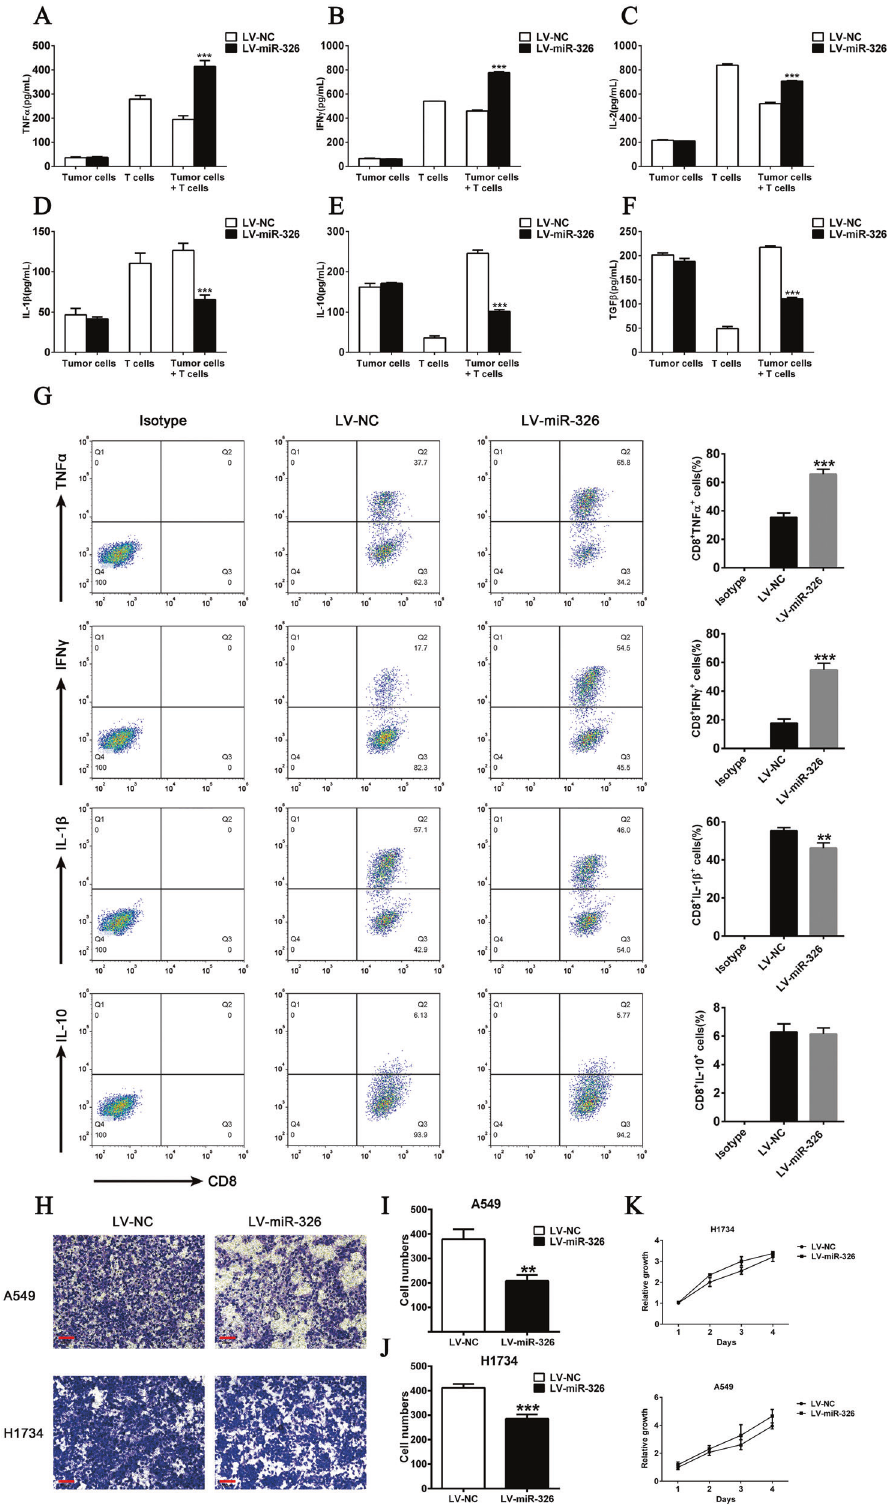
Fig. 4 MiR-326 in tumor cells regulates CD8 + T phenotype and tumor cell migration ability. A – F T cells were co-cultured with miR-NC- or miR-326-overexpressed H1734 cells. Cytokines in the supernatant were measured by ELISA ( n = 3). G TNF- α , IFN- γ , IL-10, and IL-1 β expression of CD8 + T cells after miR-326 overexpression by fl ow cytometry ( n = 3). H Transwell assay of control and miR-326-overexpressed cells. I , J Histogram of the number of migrated cells ( n = 3). K MTS analysis of the proliferation of miR-NC- or miR-326-overexpressed cells. All data were presented as mean ± SEM. Comparisons between groups for statistical signi fi cance were performed with two-way ANOVA with Tukey ’ s post hoc test ( A – F , K ) or Student ’ s t test ( G , I , J ). ** P < 0.01, *** P < 0.001 versus LV-NC. Scale bar, 200 µM.